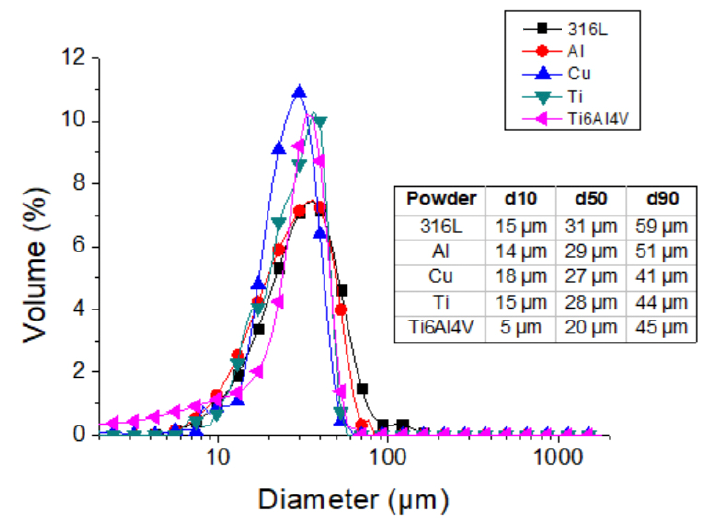
Figure 3. SEM images of feedstock powders for CSAM.